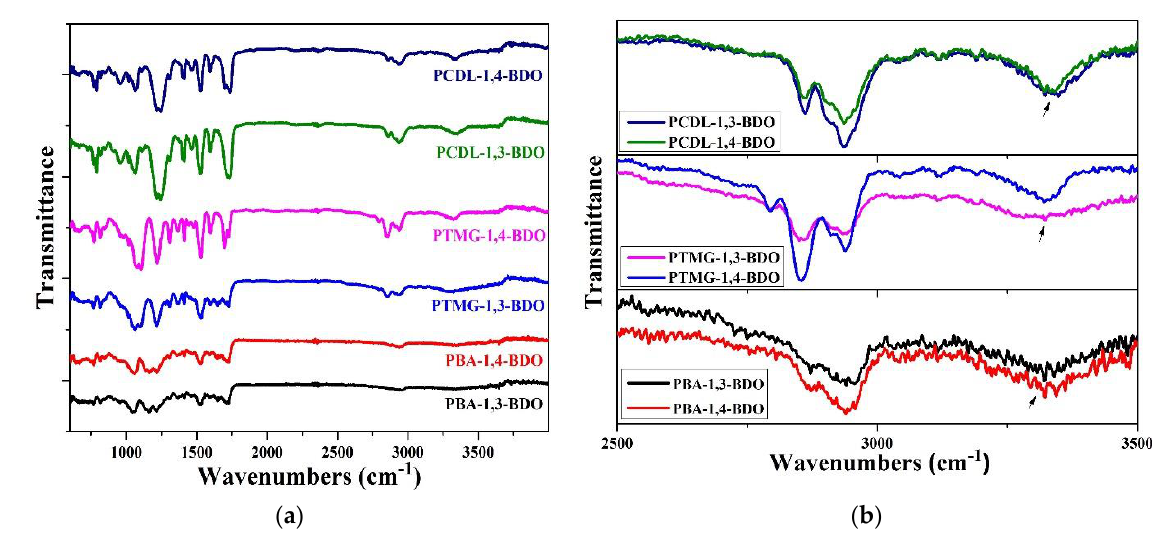
Figure 1. Fourier transform infrared (FT-IR) light spectrum diagram of the three groups of TPU, synthesized using different polyols (PBA, PTMG, or PCDL) and different chain extenders. ( a ) full graph and ( b ) graph between 2500 to 3500 cm −1 . (the arrow is located in 3300 cm −1 ).